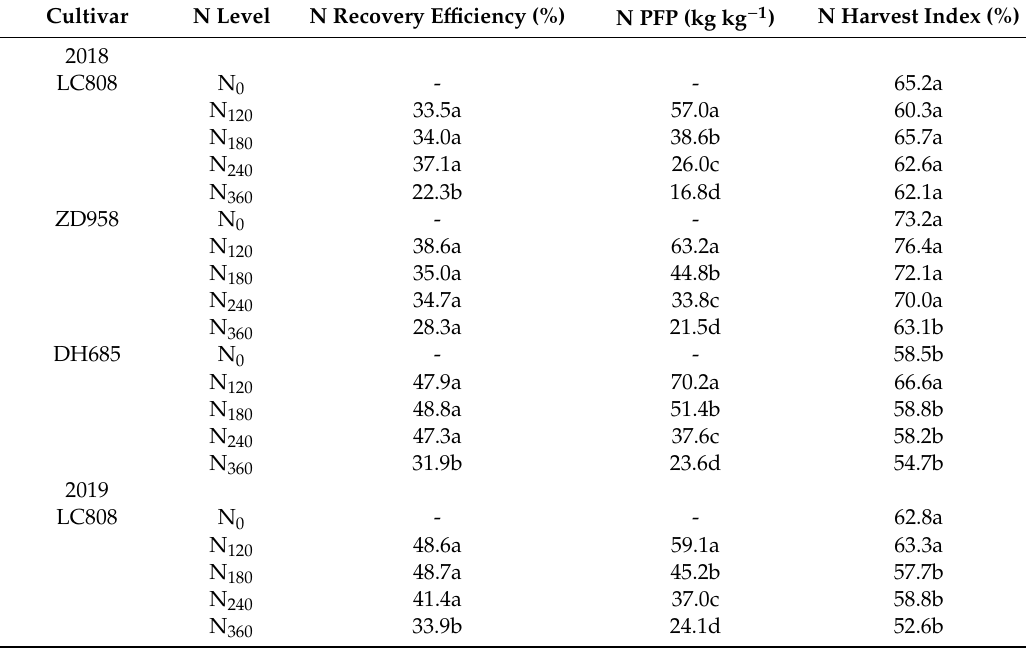
Table 2. E ff ects of di ff erent N fertilizer application rates on the N use e ffi ciencies of di ff erent types of stay-green